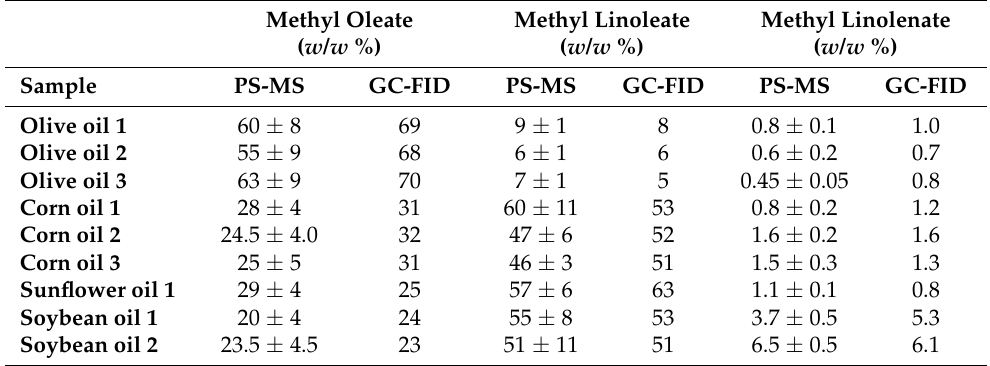
Table 3. Methyl esters amount ( w / w %) found in the investigated oil samples by PS-MS/MS and GC-FID